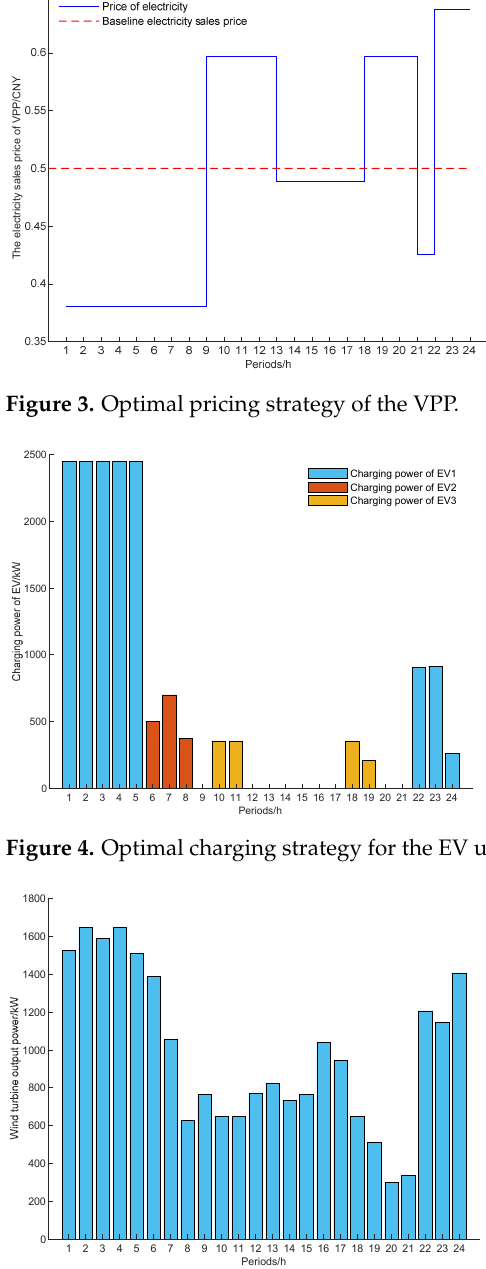
Figure 5. Wind turbine output